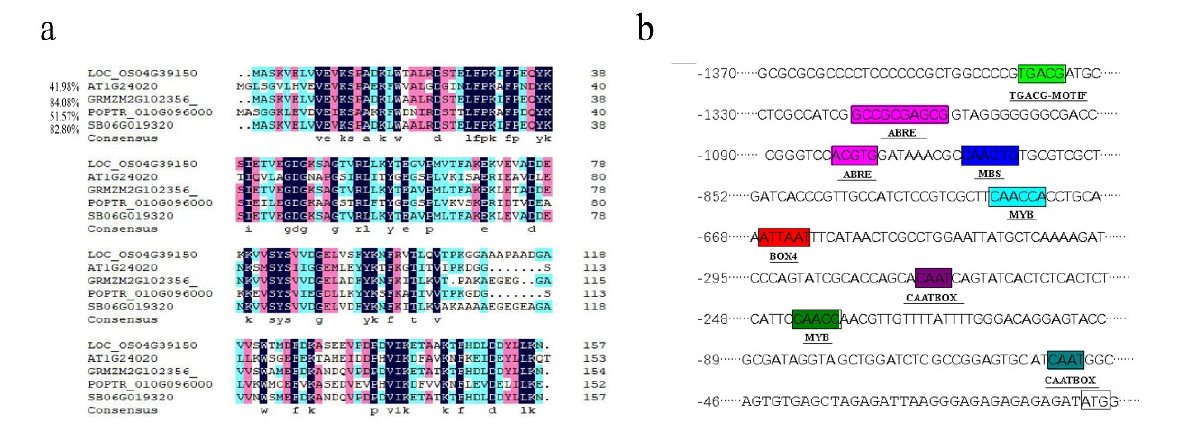
Figure 1. Bioinformatics analysis of OsMLP423 . ( a ) Analysis of homologous amino acid sequence of OsMLP423 . ( b ) Analysis of the relevant elements of the promoter region.